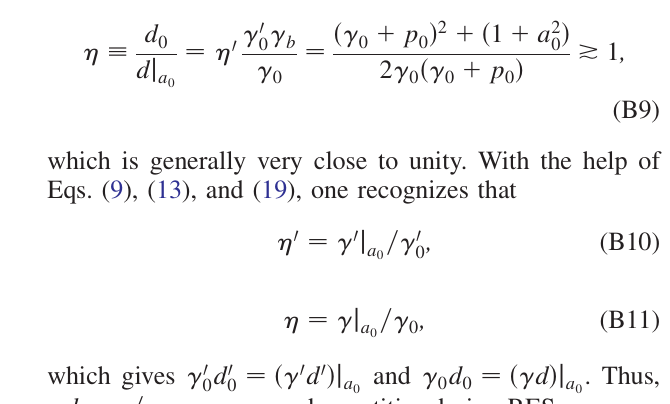
FIG. 7. Compression ratio in the boosted